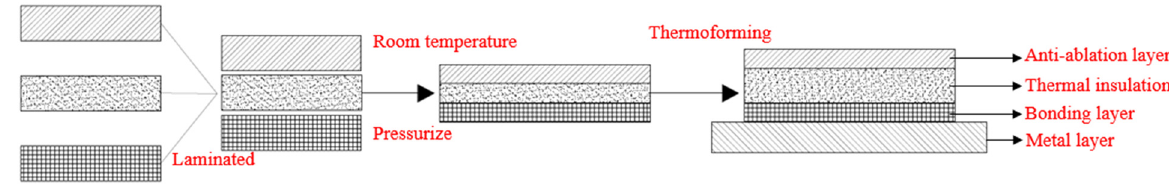
Figure 1: Preparation fl ow chart of the composite structure.